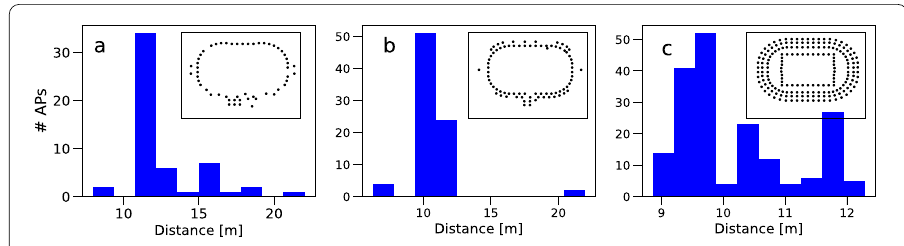
Figure 8 Histograms of nearest neighbour distances between APs on ( a ) level 4, ( b ) level 6, and ( c ) level 8. Insets show the spatial